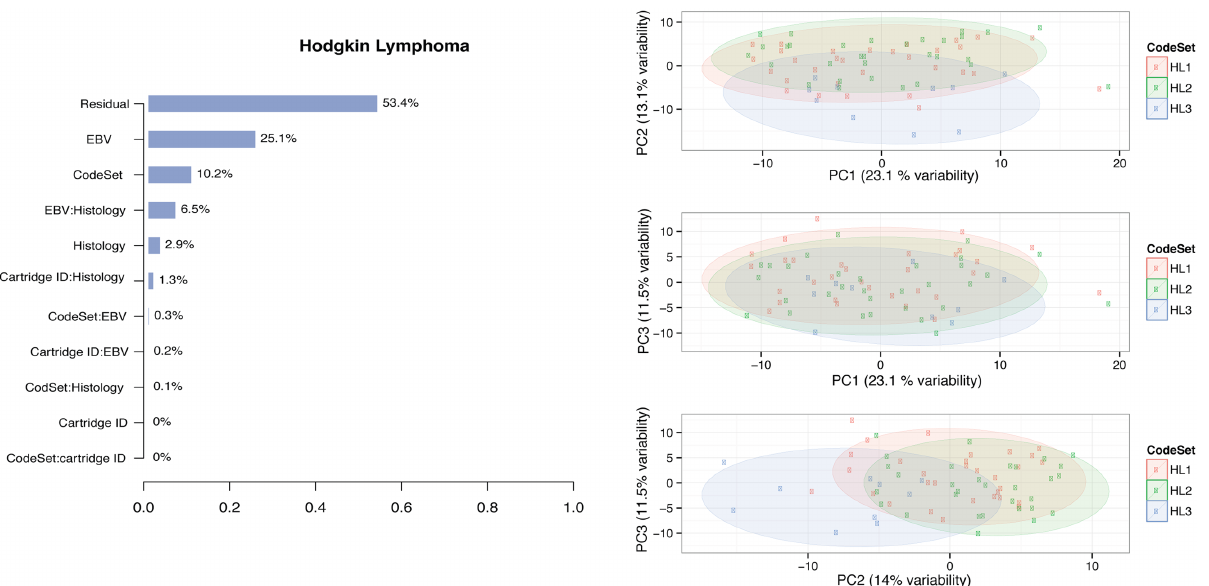
Fig 3. PVCA and PCA plots of the Hodgkin Lymphoma clinical samples. We considered the PVCA plot (A) of the HL clinical samples run in different batches. The percentages represent the variability explained by each factor and first order interaction between factors. The PCA plot (B) provides a two- dimensional summary of the pairwise plot of the first three principal components, which represent 49% of the variability in the data. HL1, HL2, and HL3 label each of unique CodeSets corresponding to the HL gene list.